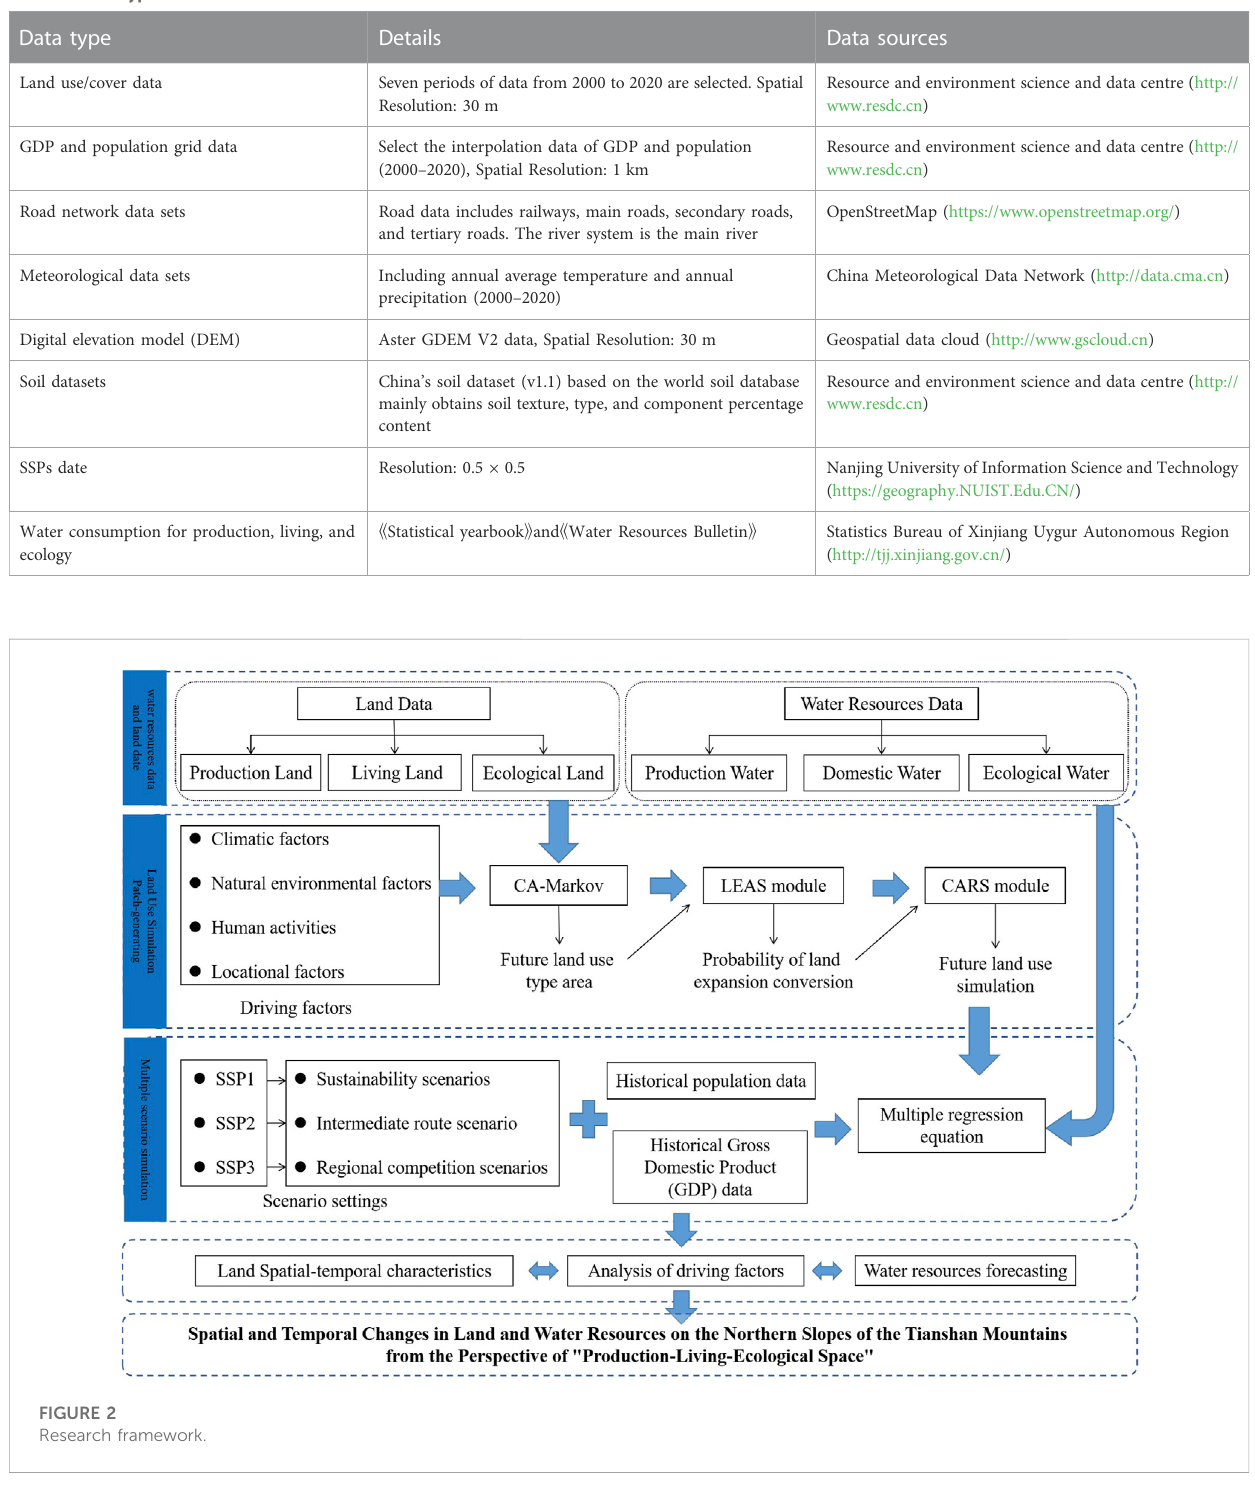
the above ideas and classi fi cation schemes for reference and adopts dominant function classi fi cation. For example, forestland can produce fruits, has ecological functions, and may also have the life function of tourism. However, the dominant function of forestland is to maintain the ecological environment, so it is classi fi ed as ecological land (Deng and Yang, 2021; Cui et al.,